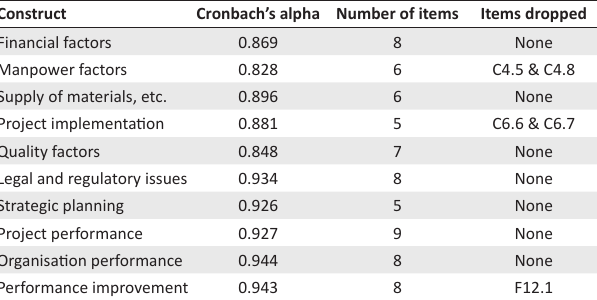
TABLE 2: Distribution of respondents by demographic characteristics.